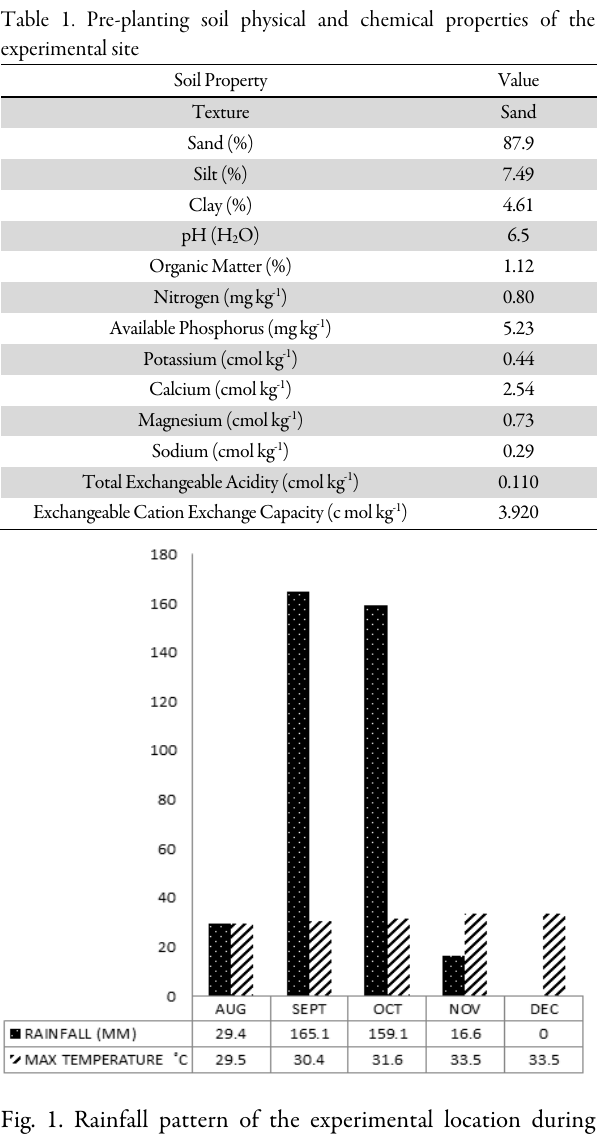
Fig. 2. Interaction of CO enrichment × AMF inoculation × 2 variety on seed yield, screen house. Bars in each column indicate standard error of mean